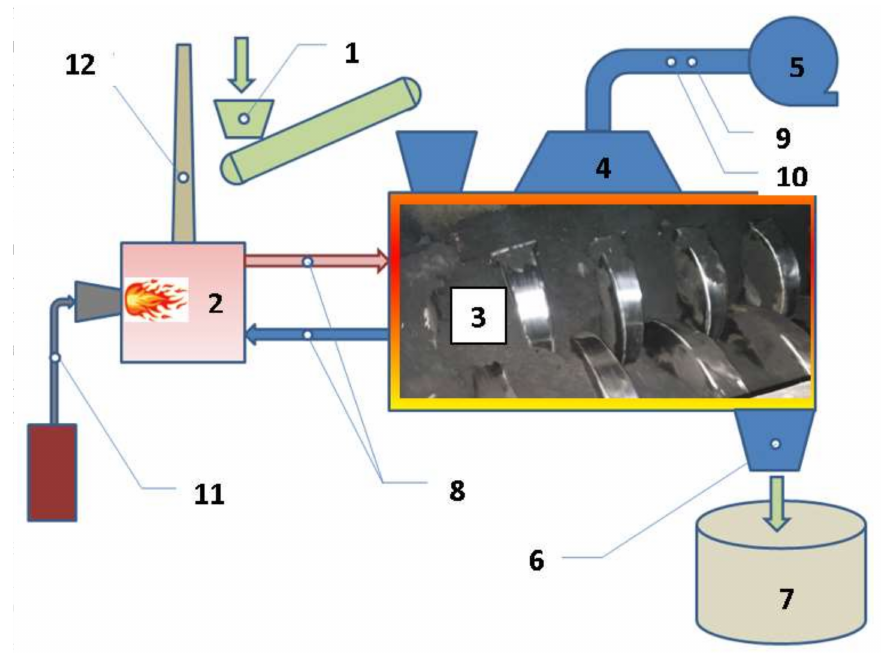
Figure 1. Diagram of the paddle dryer used for drying tests (1—feeding line of wet sewage sludge; 2—thermal oil boiler with oil burner; 3—paddle dryer; 4—outlet of the mixture of air and vapors; 5—extraction fan; 6—outlet of dried sewage sludge; 7—tank with dried sewage sludge; 8—temperature measurement for hot thermal oil supply and return; 9—sampling of the vapors with measurement of the velocity and temperature; 10—measurement of the relative humidity; 11—supply of the fuel oil to the burner;